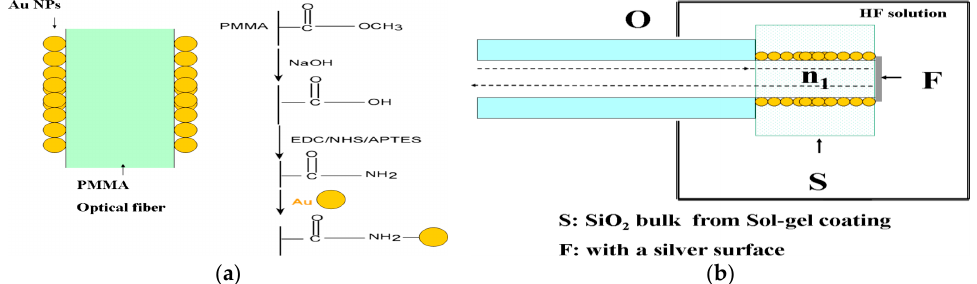
Figure 14. ( a ) The diagram of gold nanoparticles immobilized on PMMA optical fiber by using a sol-gel coating. ( b ) Schematic diagram of the reflection-based LSPR fiber-optic probe. Reproduced from [137] with permission from Chen et al. (2011).